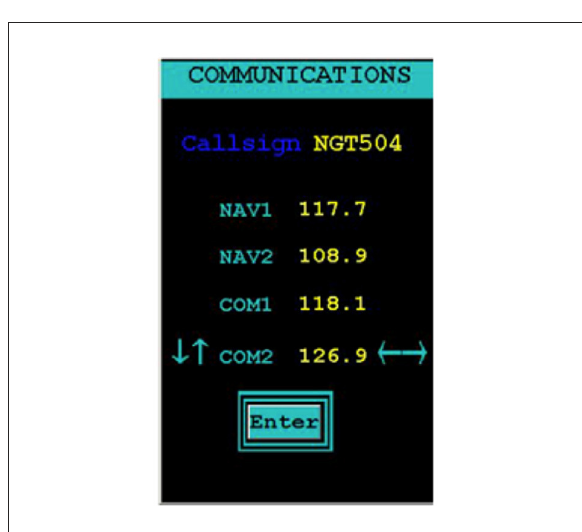
FIGURE2 The Communications (C) subtask in the AF-MATB